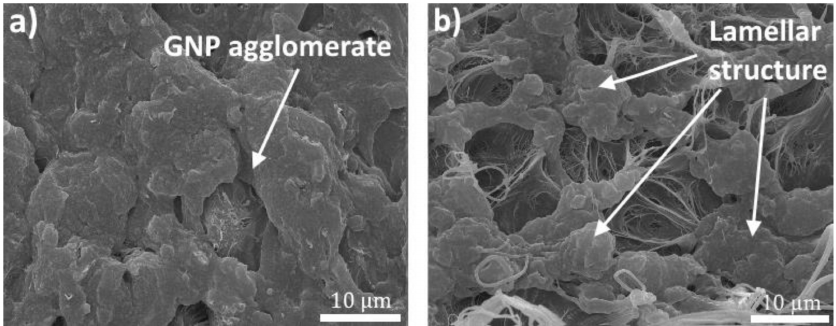
Figure 6. SEM micrographs showing typical supramolecular structure of the UHMWPE xerogels with